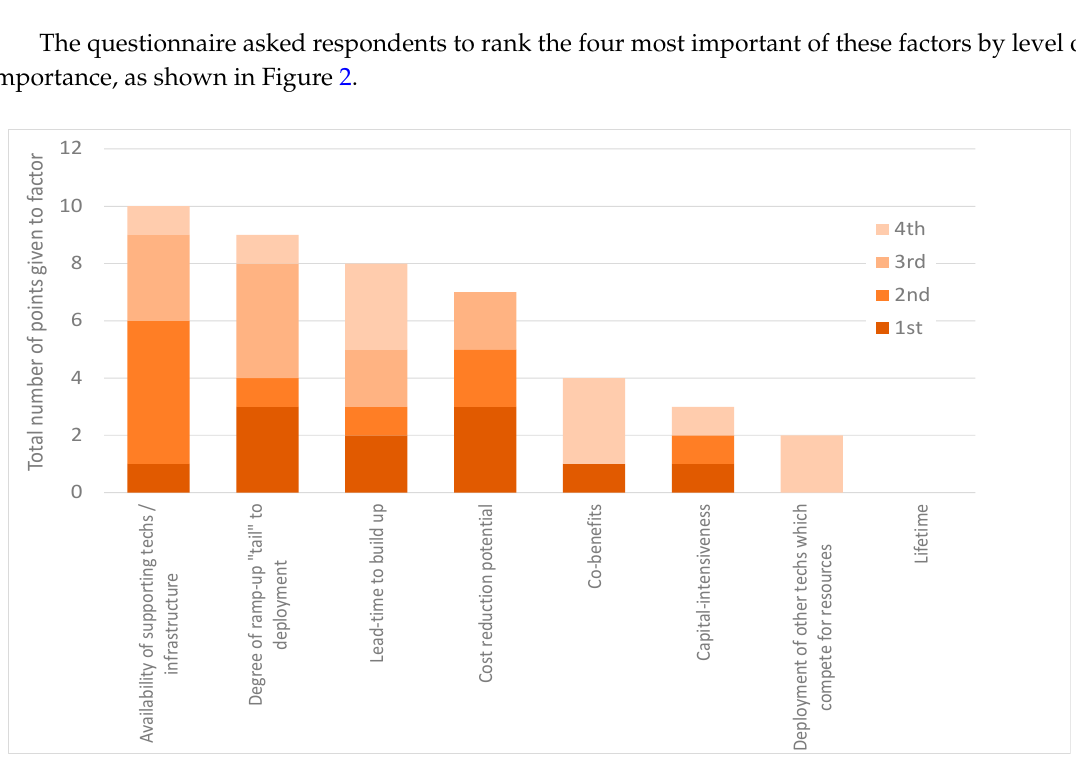
Figure 2. Number of respondents identifying each factor (with relative importance ranking) for assessing the feasibility of technology deployment rates in low-carbon scenarios.